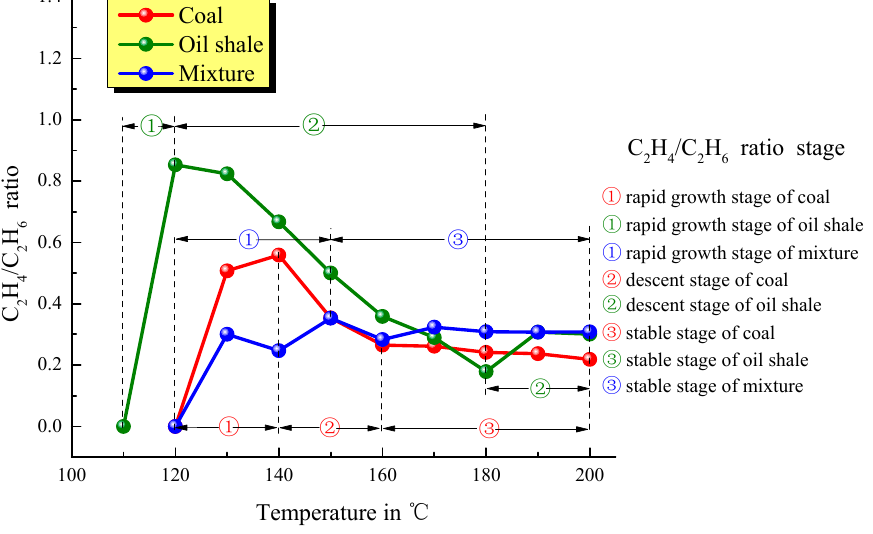
Table 4. Three sample stages divided with respect to the CO/CO 2 ratio.